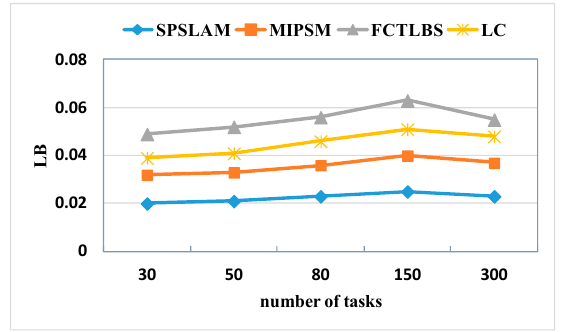
Figure 2. Load balancing degree of four scheduling algorithms.